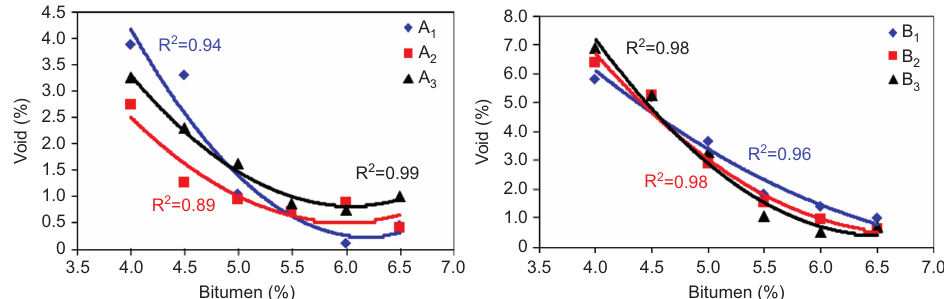
Figure 8 Relation between % bitumen and % void.